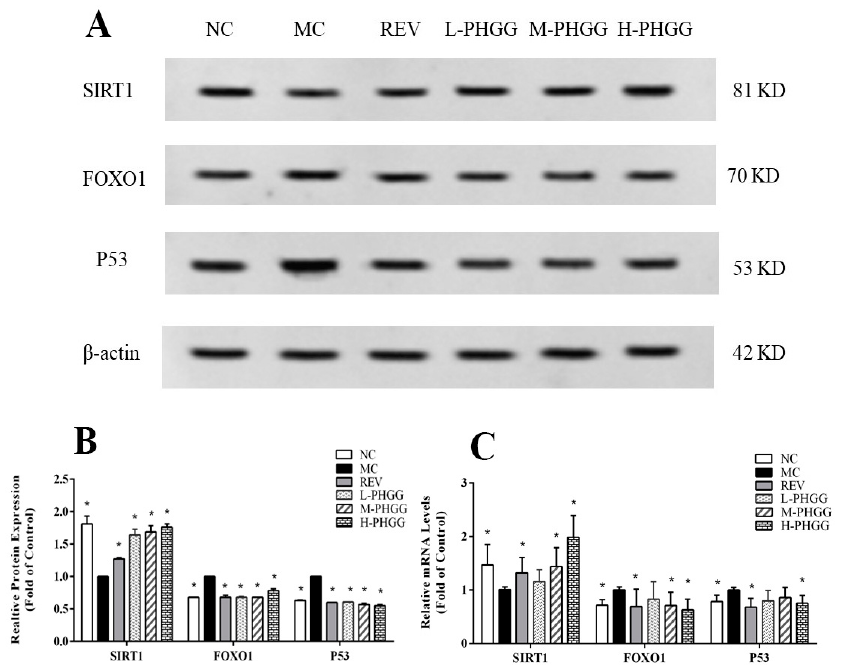
Figure 3. Effects of PHGG on the levels of sirtuin 1 (SIRT1), Forkhead box O 1 (FOXO1), and tumor protein P53 (P53) protein expression in the rat hippocampus. ( A ) A representative image of the Western blotting assay. ( B ) The presented data of the Western blotting assay are expressed as the fold change compared with the NC control, which was arbitrarily set to 1. ( C ) The mRNA levels of SIRT1, FOXO1 and P53 genes relative to GAPDH and normalized with the control, which was arbitrarily set to 1. Statistical significance between the model control group and the other groups was determined by the Kolmogorov–Smirnov test and Levene’s test for hypotheses of normality and variance homogeneity, followed by Student’s t -test or Mann–Whitney’s U non-parametric test. * p < 0.05 compared with the model control group. NC, normal control (saline); MC, d -gal model control (saline); REV, resveratrol (20 mg / kg / day); L-PHGG, 500 mg / kg / day; M-PHGG, 1000 mg / kg / day; H-PHGG, 1500 mg / kg /